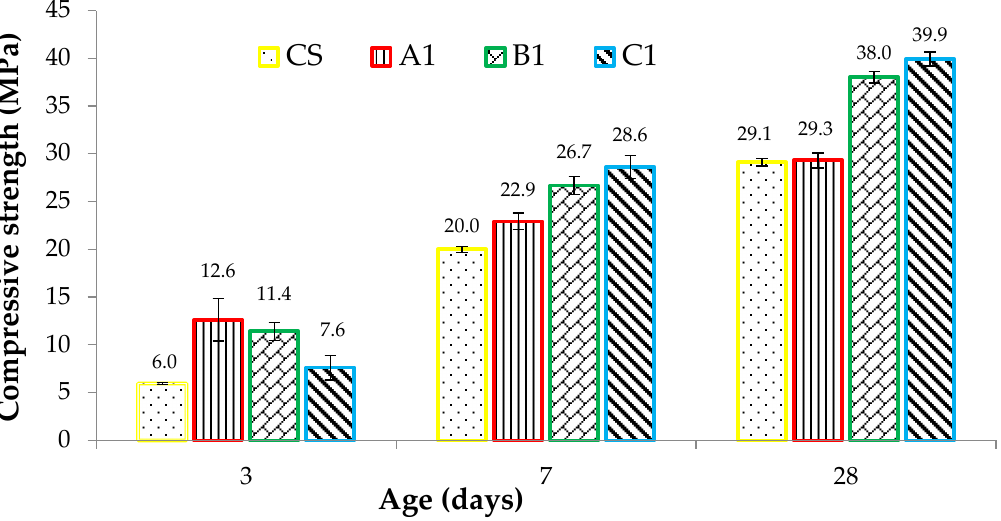
Figure 8. Compressive strength results of standard concrete and ferro-cement cube samples.